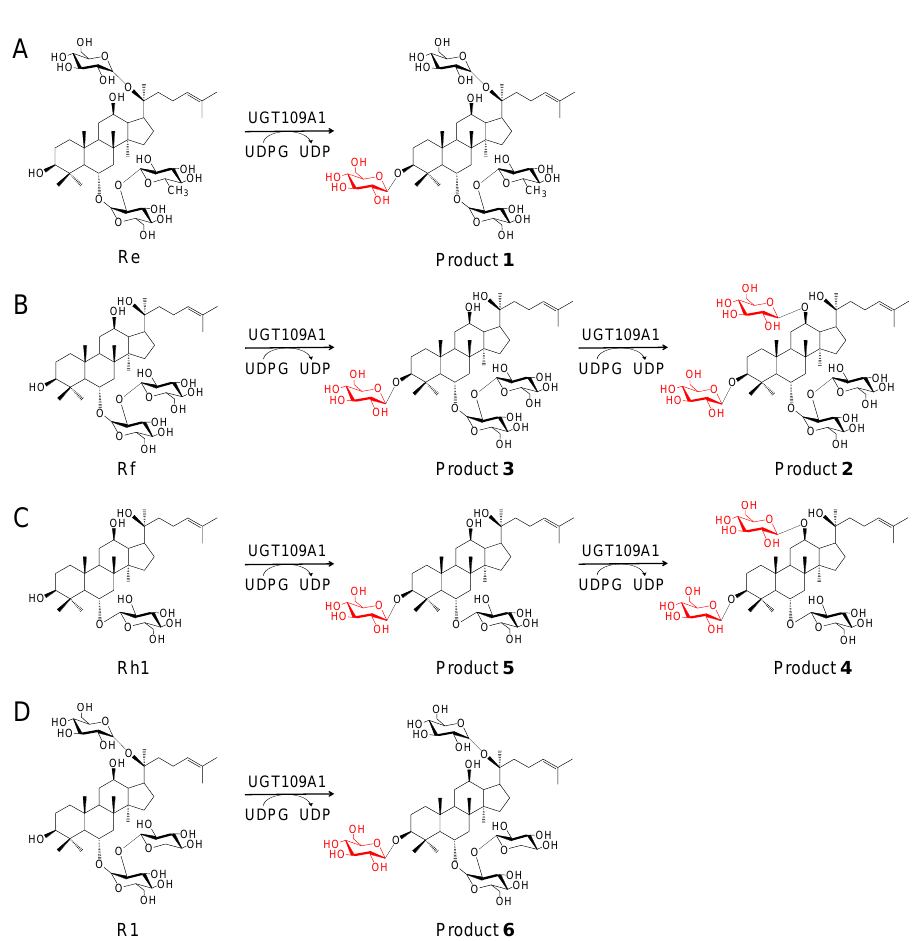
Figure 4. Glycosylation patterns of UGT109A1 toward ginsenosides Re ( A ), Rf ( B ), Rh1 ( C ), and R1 ( D ).